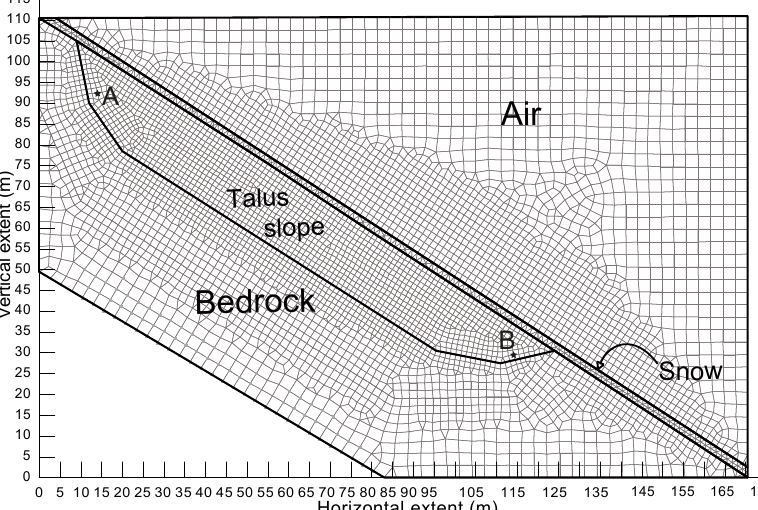
Figure 2. Model set-up and mesh showing the four subdomains used in the talus slope experiments. The points (nodes) marked by A and B are reference points which are further analysed below. Table 1. Material properties used for the GeoStudio simulations in this study (based on Schneider, 2014; Arenson and Sego, 2006; Arenson et al., 2007; Scapozza et al., 2015; see text). The snow layer only acts as an idealised boundary that seasonally damps and prohibits air exchange between talus and atmosphere through coupling of the air conductivity value to the snow height. See text for further explanations. Material Thermal conductivity Specific heat Vol. heat Porosity Air capacity capacity